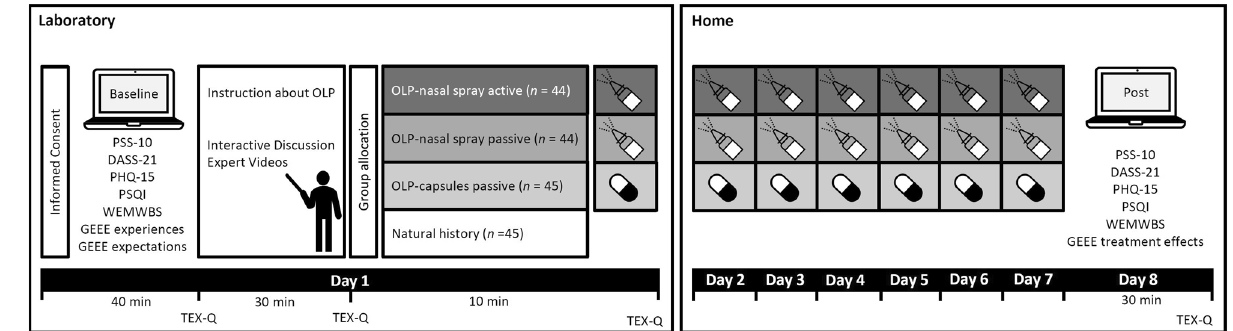
Figure 3. Experimental